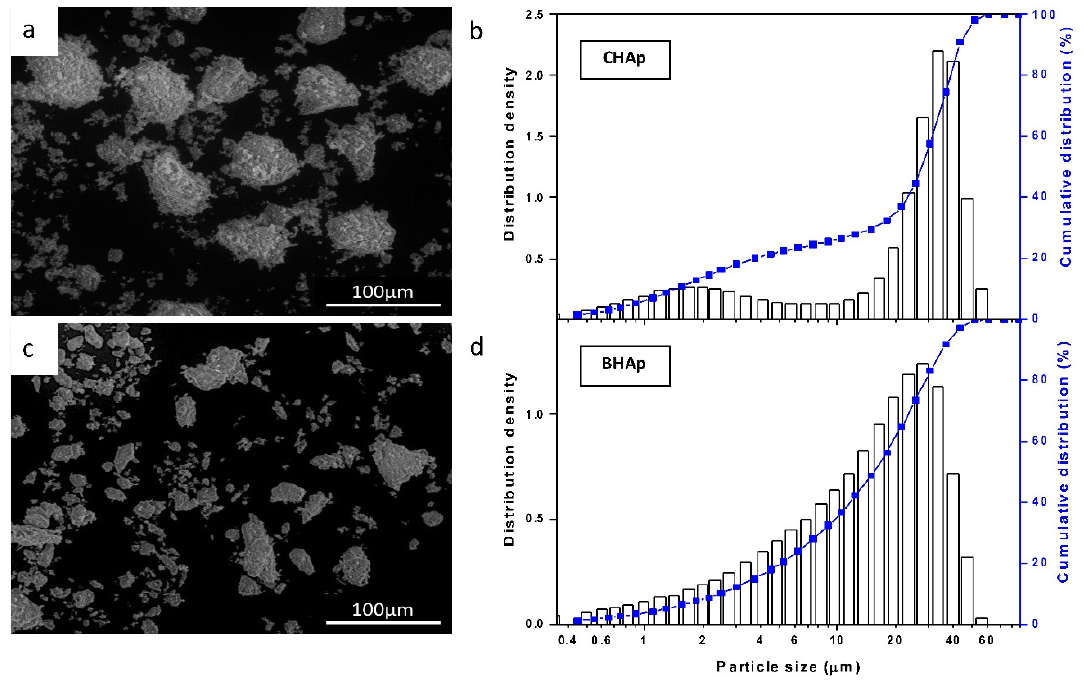
Figure 1. Morphology and particle size distribution for: CHAp ( a , b ); and BHAp ( c , d ).